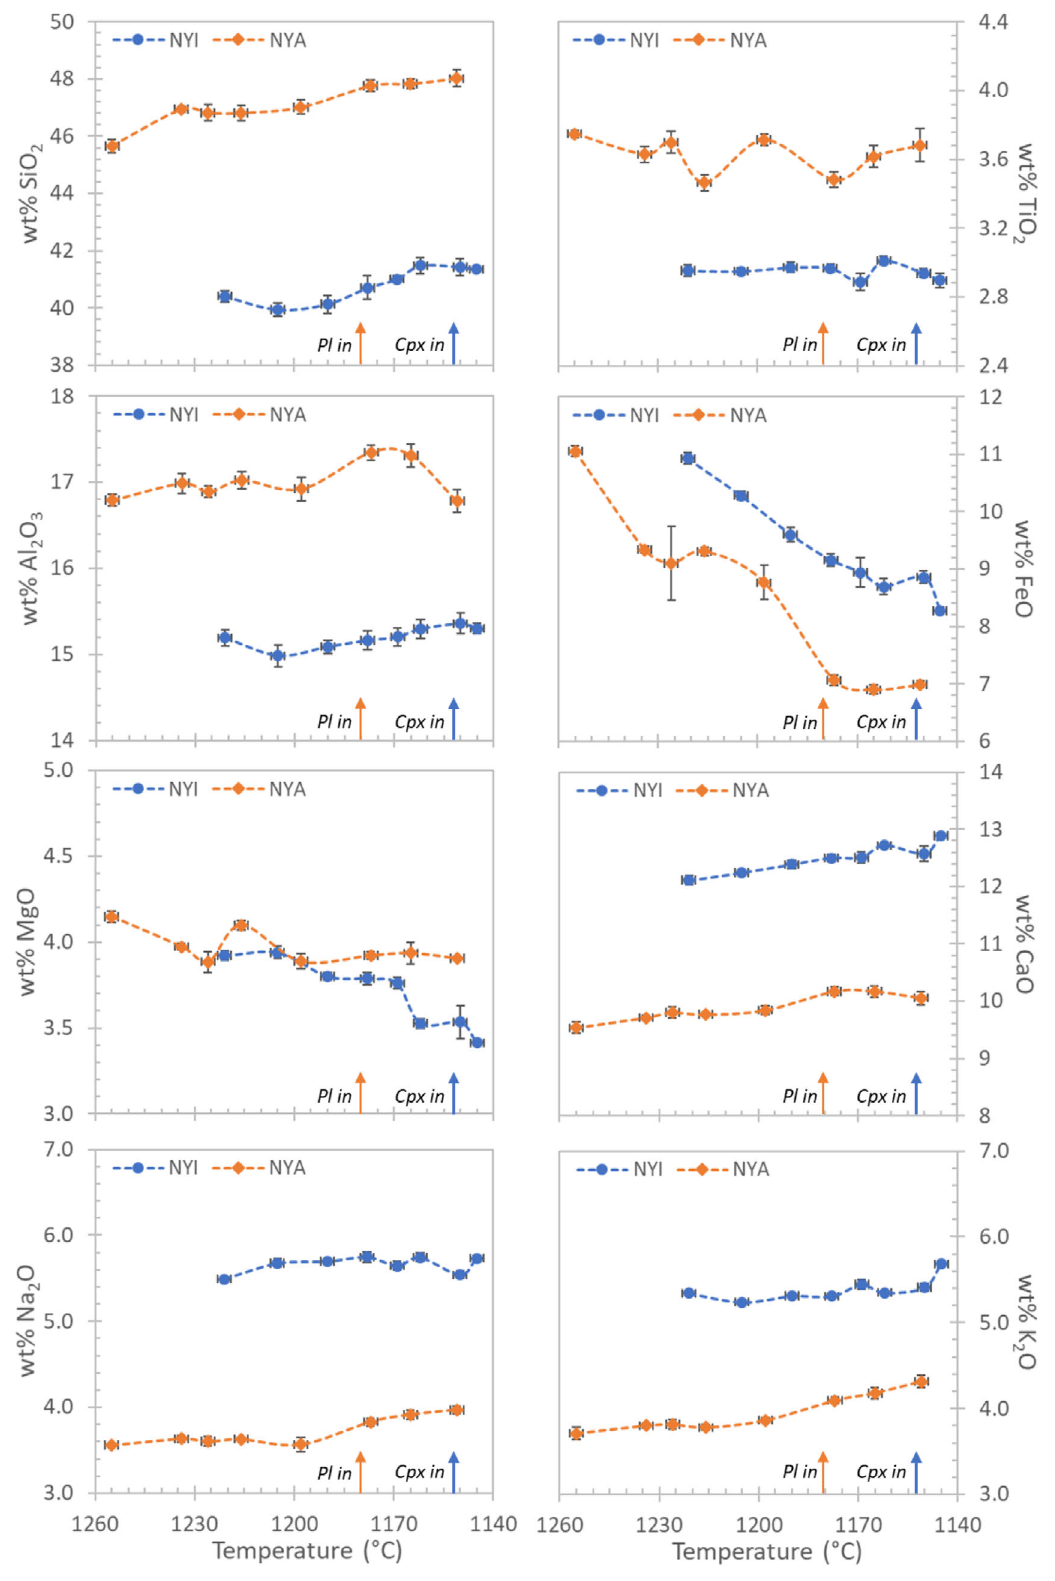
Figure 6: Melt chemistry evolution for Nyiragongo (blue circles) and Nyamuragira (orange diamonds) compo- sitions. Data points represent the average of 6–8 EPMA analyses of interstitial glass from a given subliquidus temperature. Onset of pyroxene crystallization for the NYI sample and the onset of plagioclase crystallization for the NYA sample are indicated by the